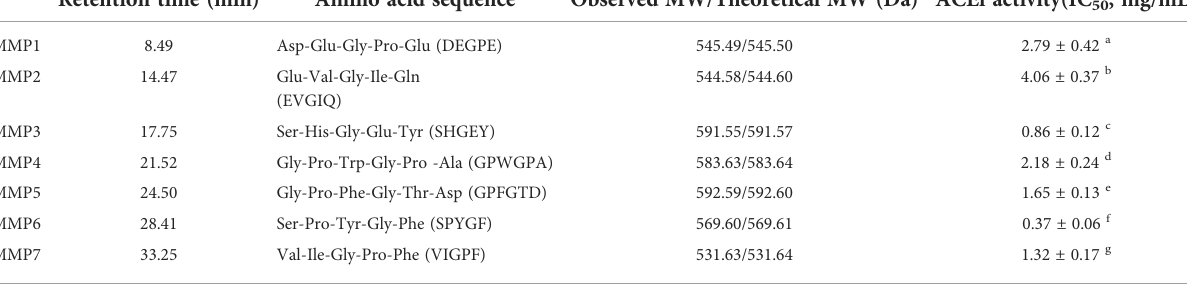
TABLE 2 Amino acid sequences, molecular weights (MWs), and ACEi activity (IC 50 value) of seven isolated ACEi peptides (MMP1- MMP7) from swim bladder hydrolysate of miiuy croaker (MSCH). Retention time